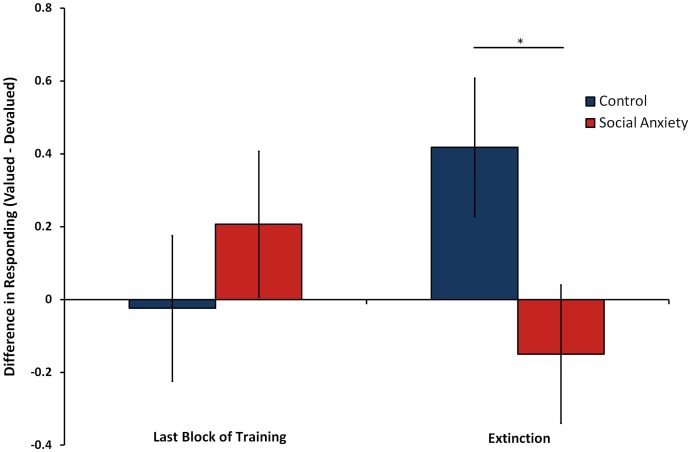
Difference in mean rates of responding for actions predicting valued relative to devalued outcomes over the last block of training and extinction trials in controls compared to social anxiety disorder patients.Error bars depict standard error of the mean difference between controls and patients. *p<.05.